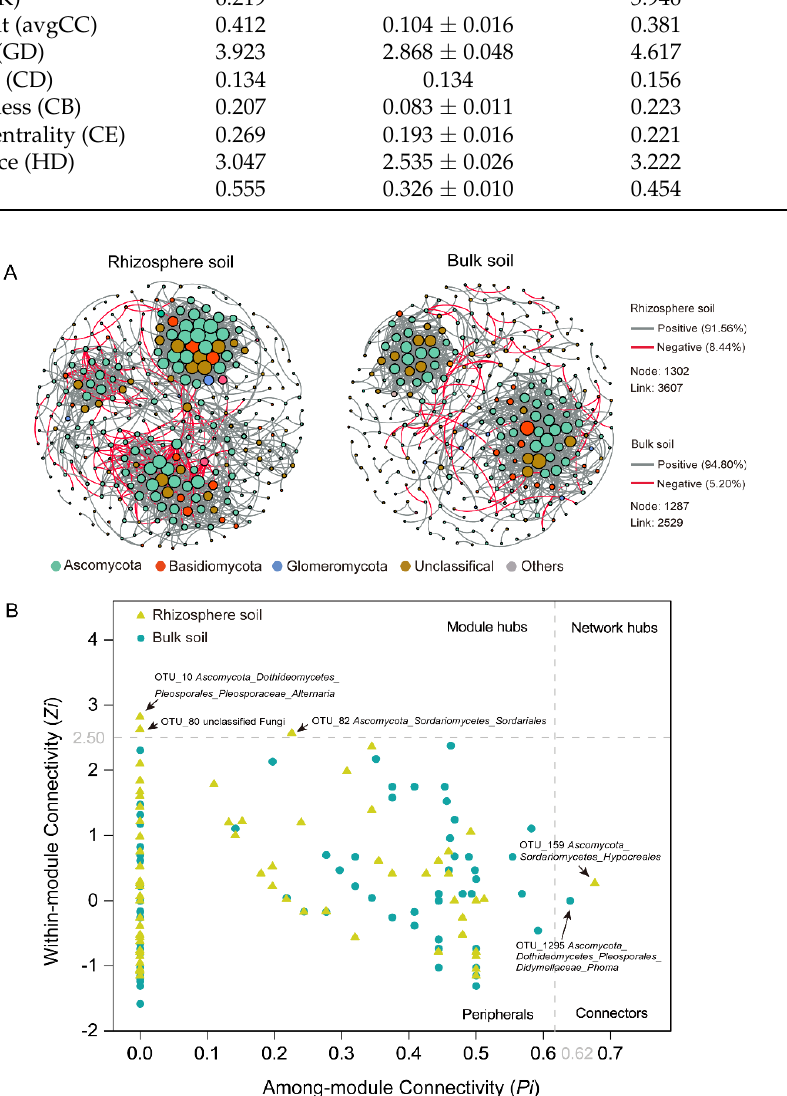
Figure 5. Co-occurrence network interactions of the rhizosphere and bulk soil fungal communities in the four plant species ( A ); and Z i – P i plot indicating the topological distribution of OTUs in the fungal network ( B ). The size of each node is proportional to the relative abundance.